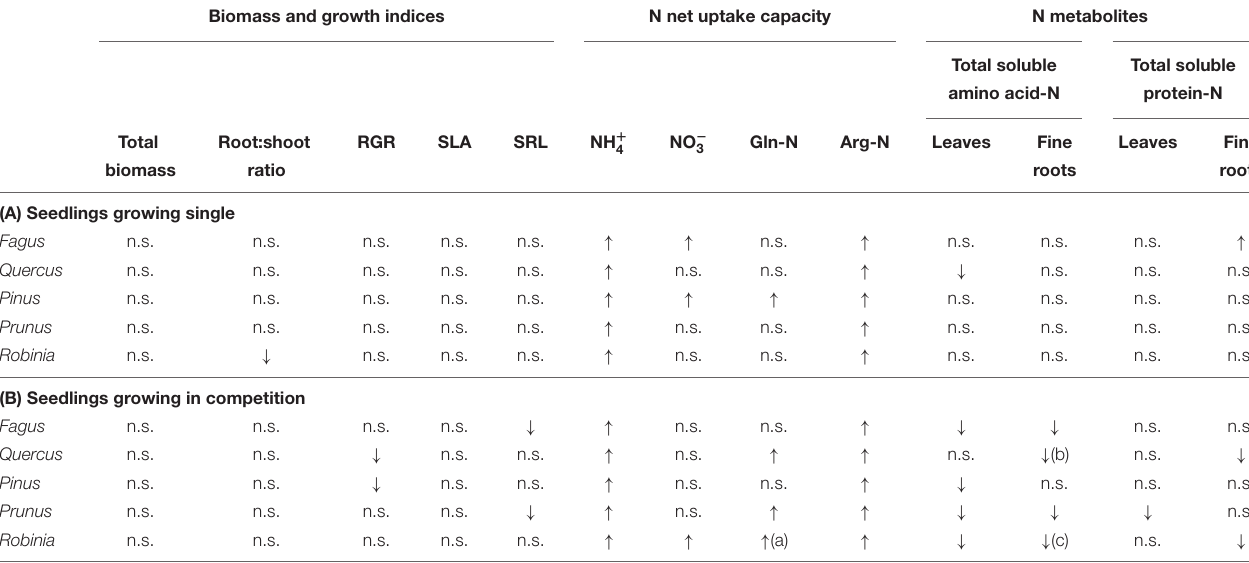
TABLE 2 | Effects of increased soil N availability on total biomass, growth indices, inorganic and organic N net uptake capacity, and N metabolite levels on (A) seedlings growing single and (B) seedlings growing in competition of Fagus sylvatica, Quercus robur, Pinus sylvestris, Prunus serotina , and Robinia pseudoacacia . Biomass and growth